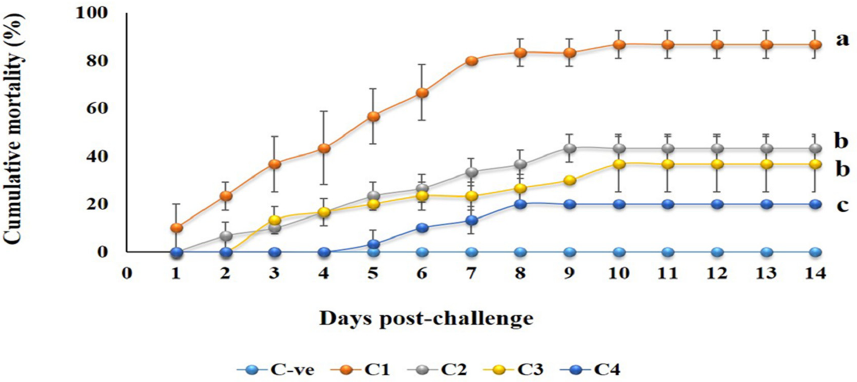
Figure 2. The cumulative mortality (%) over time (Days 0–14) for Pacific white shrimp, Litopenaeus vannamei , after challenge with Fusarium solani ; shrimp were fed with β -1,3 glucan and fructooligosaccharides ( β -1,3 GF) supplemented diets (0, 0.5, 1, 1.5 g/kg; C1–C4, respectively). C-ve, refer to shrimp groups that received a normal basal diet and were intramuscularly injected with PBS. Means (SD±) with different letters are significantly different ANOVA test, at p ≤ 0.05.